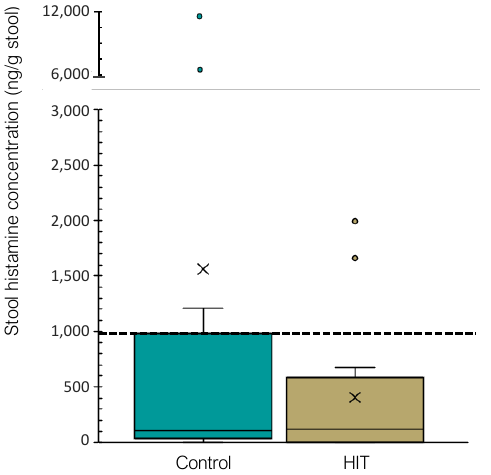
Figure 4. Occurrence of histamine (ng/g stool) in fecal samples of control and HIT groups. Samples above the dotted line are above the normal range (<959 ng/g stool). Mean values are represented with an × and values statistically considered as outliers (atypical values) are plotted as circles.